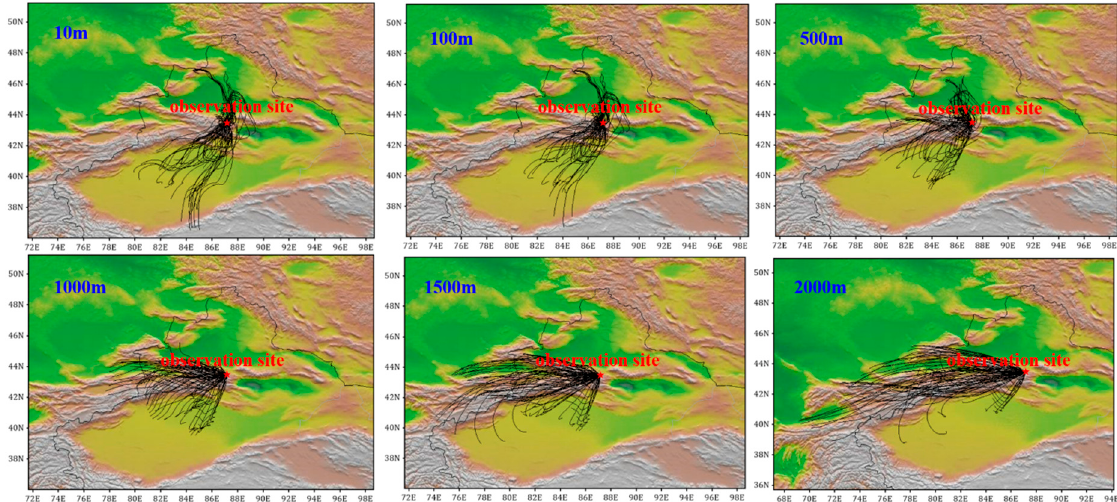
Figure 9. 48 h backward trajectory at different heights above observation site every 3 h.